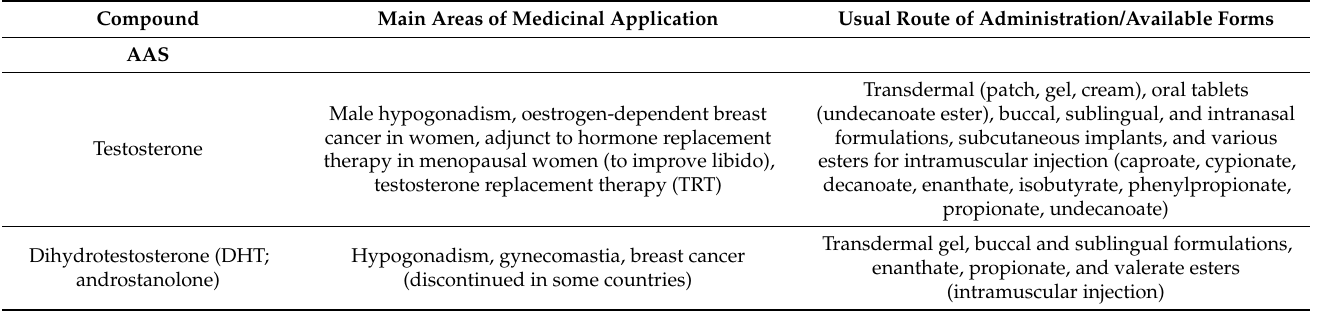
Table 1. Medicinal use, usual routes of administration, and available forms of compounds discussed in this review. Compound Main Areas of Medicinal